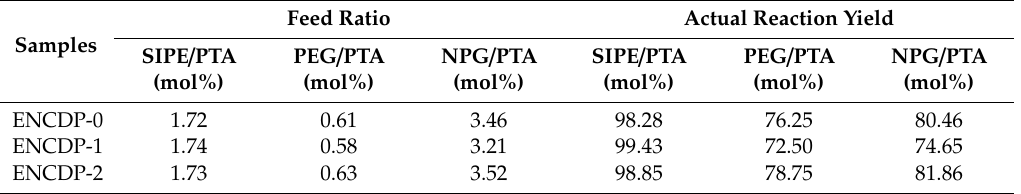
Table 4. The actual reaction yield calculated from 1 H-NMR spectra of samples.